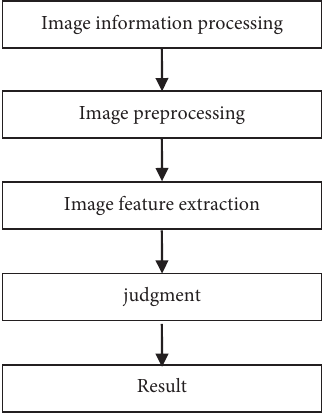
Figure 3: Treatment process of image